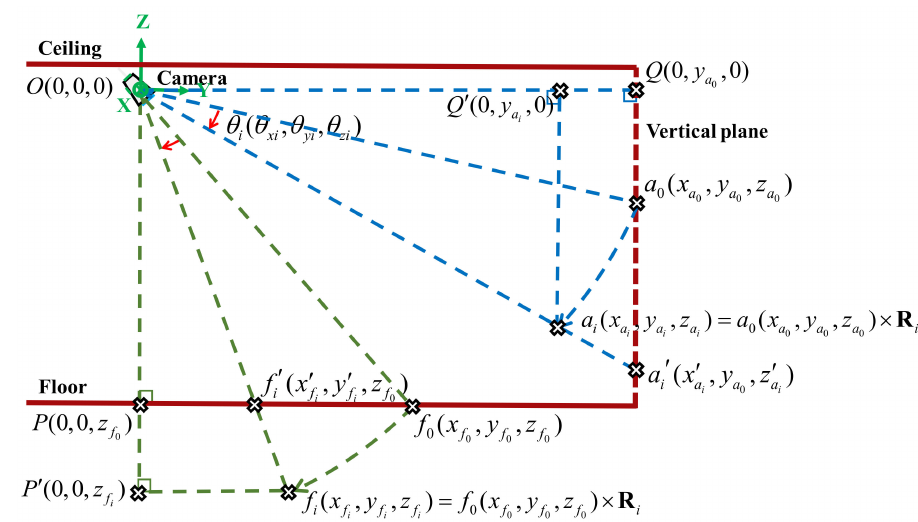
Figure 5. Schematic diagram (side view) describing the geometrical relationships between the camera and the target points whenq the camera